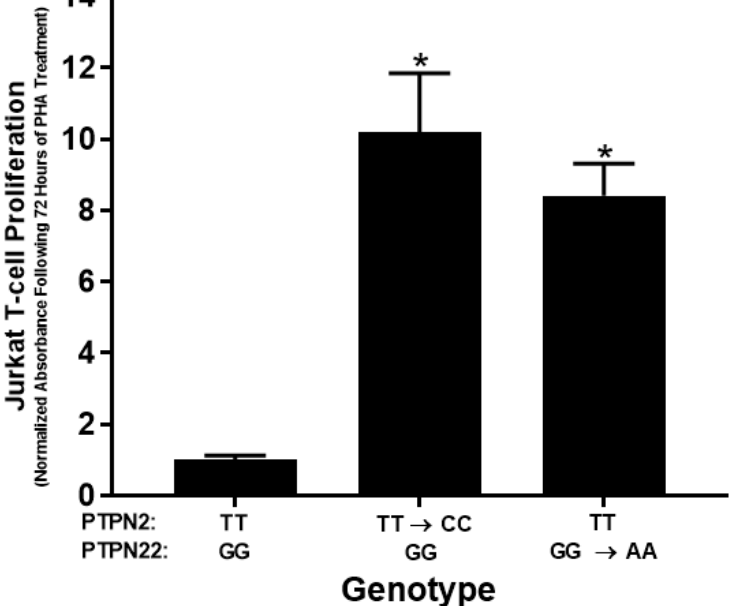
Figure 3. Effect of PTPN2/22 SNPs on Proliferation in CRISPR-Cas9-edited Jurkat T-cells Stimulated with PHA. BrdU-labeling proliferation ELISA was used to measure proliferation in WT, PTPN2 SNP, and PTPN22 SNP Jurkat T-cells stimulated with PHA (10 μ g/mL) after 72 h ( n = 3). * p < 0.05.